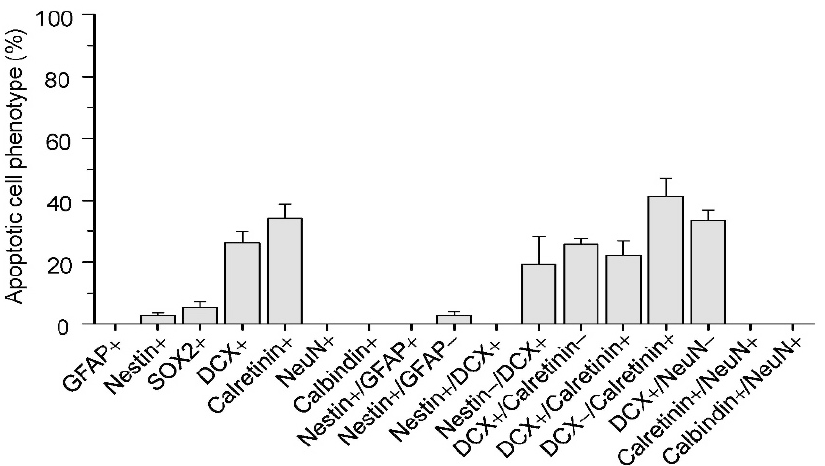
Figure 3. Phenotypes of apoptotic cells in subgranular zone after irradiation. Data represent mean ± standard error, n = 3 mice.